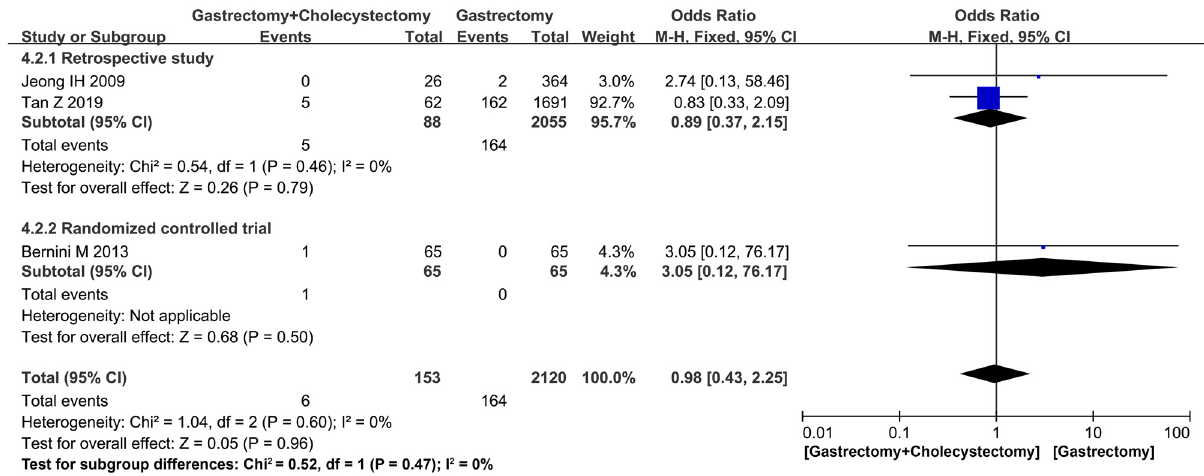
Figure 3: Forest plot showing postoperative biliary